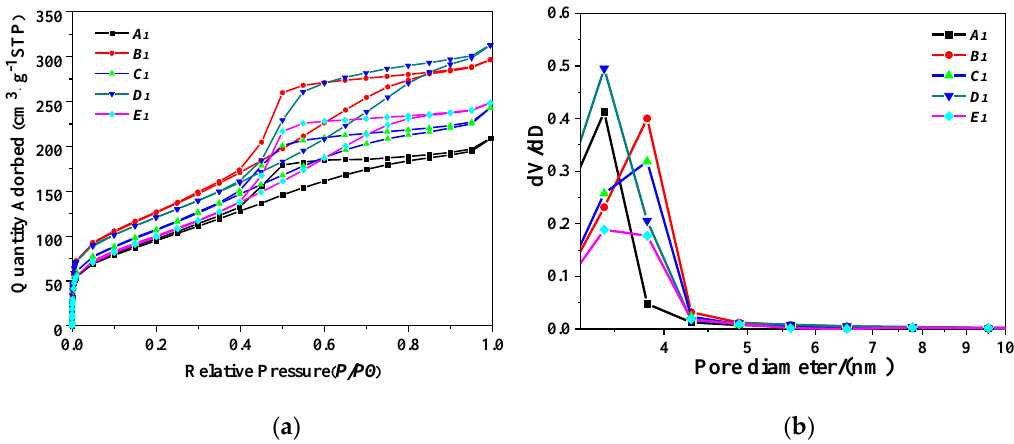
Figure 6. ( a ) N 2 adsorption–desorption isotherm results of PB with di ff erent gas–liquid ratios, ( b ) pore size distribution of PB with di ff erent gas–liquid ratios (concentration of NaAlO 2 solution, 0.1 mol / L; rotating speed of CF-RPB, 600 rpm).